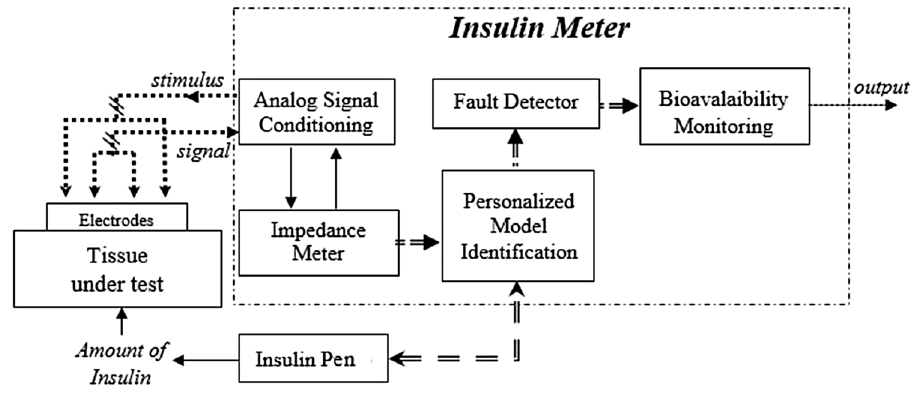
Figure 1. Architecture of the insulin